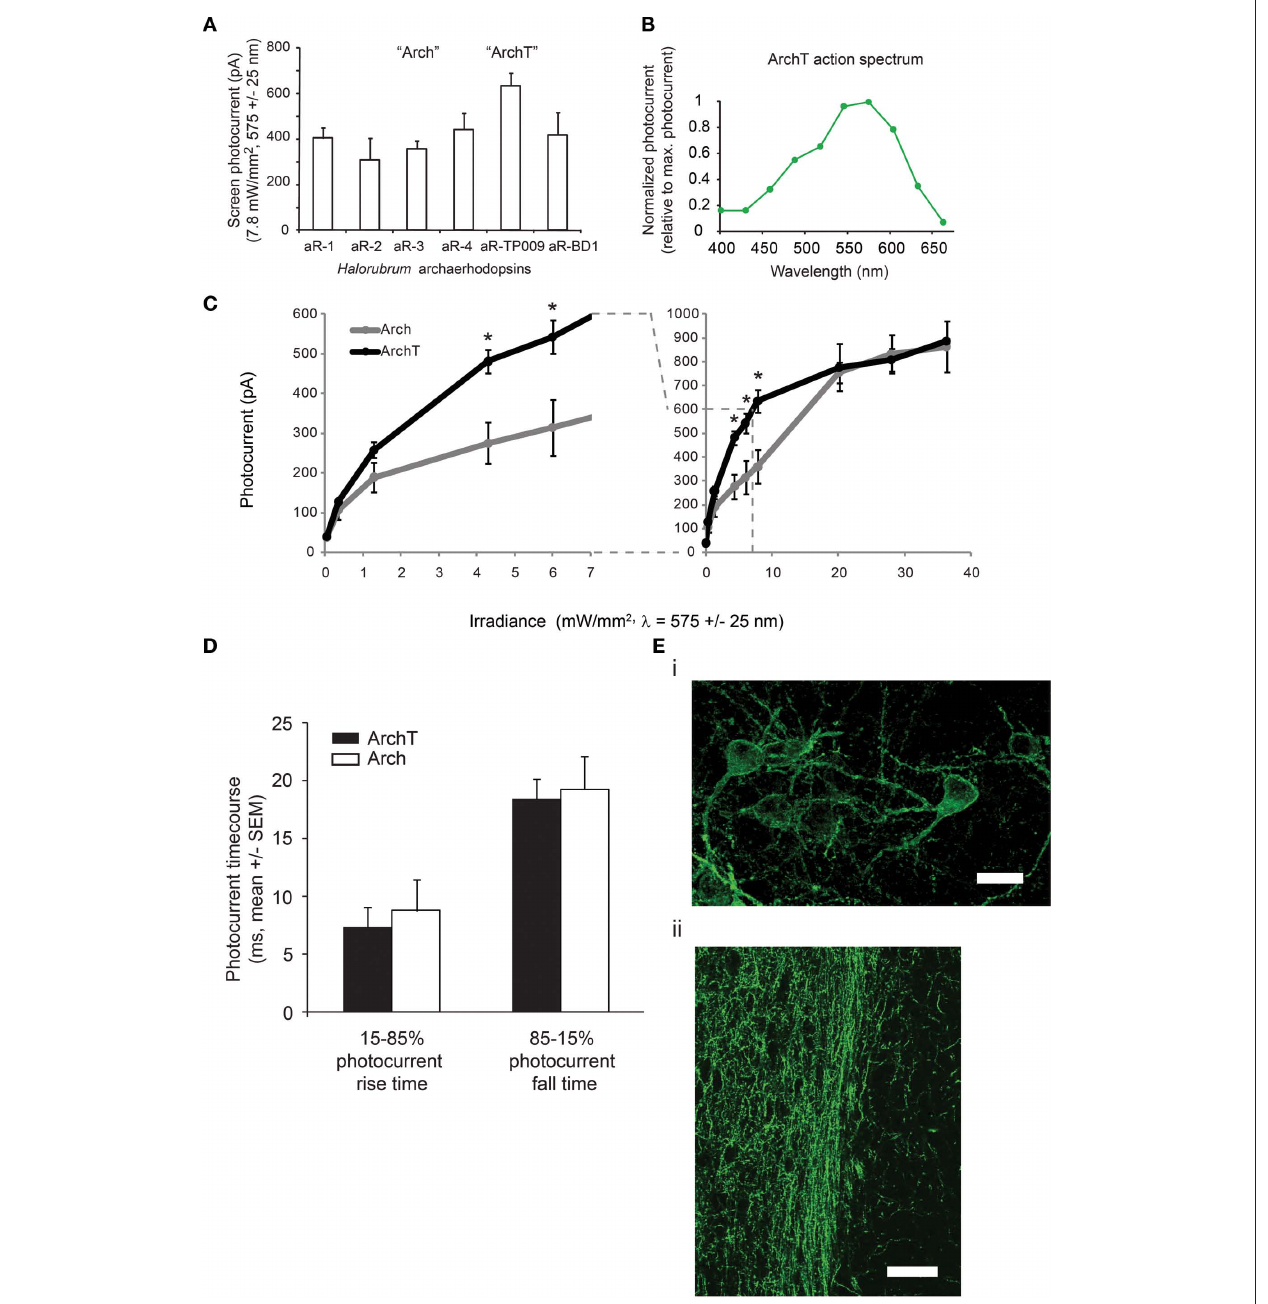
the visible spectrum ( n = 8 neurons). (C) Photocurrents of ArchT and the previously published reagent Arch measured as a function of 575 ± 25 nm light irradiance ( n = 4–16 neurons for each point); curves are Hill plots. * p < 0.05, t -test. (D) Rise times and fall times (measured from the time that the current takes to ramp up from 15 to 85% of its maximum value, and to decline by the same amount) for ArchT vs. Arch-mediated photocurrents in neurons. (ei) Fluorescence image showing lentiviral ArchT-GFP expression in mouse motor cortex, ∼ 1 month after lentiviral injection. Scale bar, 15 μm. (eii) Fluorescence image showing lentiviral ArchT-GFP expression in the axons of mouse infralimbic cortex neurons, here projecting into the nucleus accumbens shell, ∼ 1 month after lentiviral injection. Scale bar,